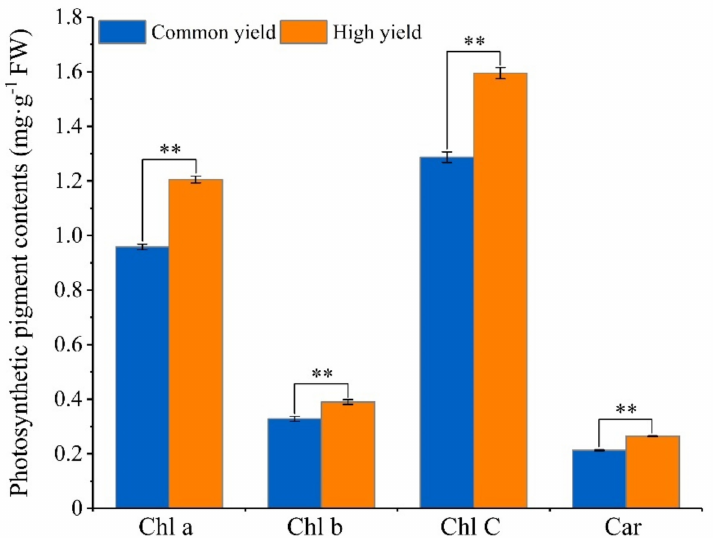
Figure 1. Photosynthetic pigment contents of masson pine needles in the high and common resin yield. FW means fresh weight. “Common yield” means the common resin-yielding clone, and “High yield” means the high resin-yielding clone. Error bars refer to the standard deviation (SD) of three biological replicates. ** indicates a significant difference between the high and common ones at p < 0.01. Chl a, chlorophyll a; Chl b, chlorophyll b; Chl C, total chlorophyll; Car,